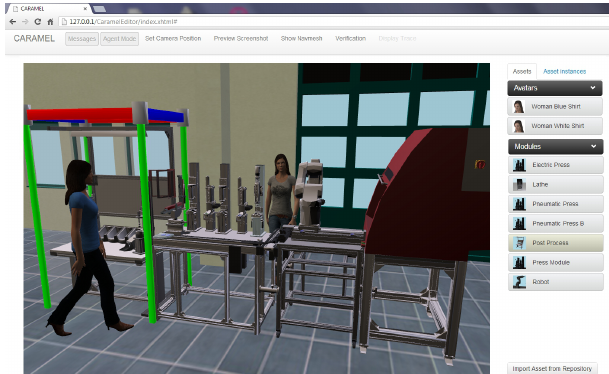
Figure 6. Editor for agent-controlled